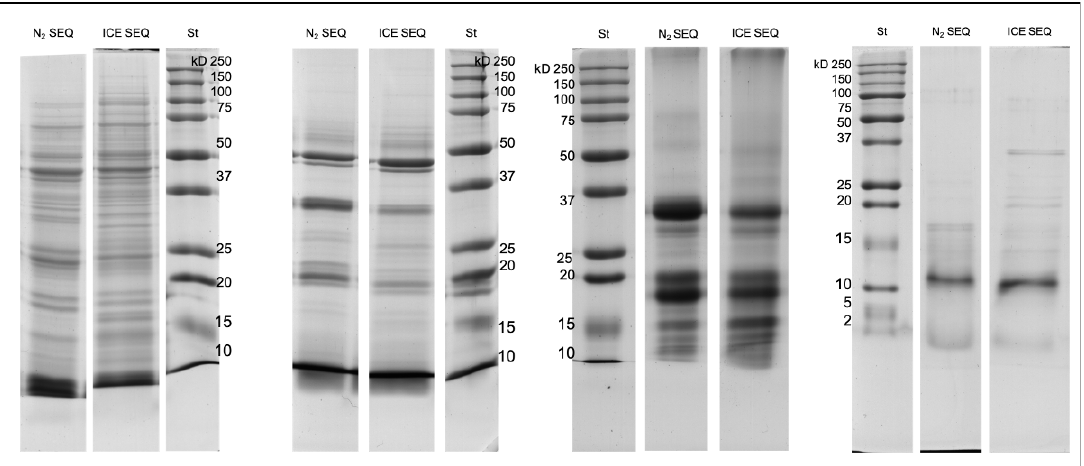
Figure 4. SDS PAGE of different protein fractions, from left to right: N 2 and ICE albumins, N 2 and ICE globulins, N 2 and ICE glutelins. N 2 and ICE prolamins.